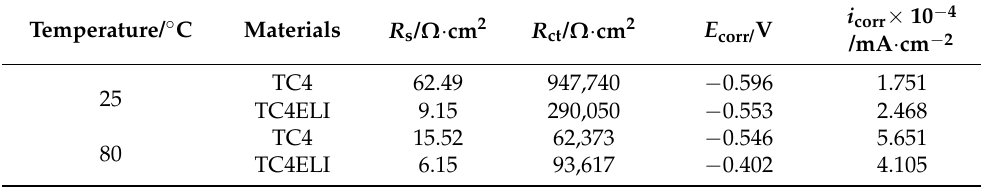
Table 8. Electrochemical parameters of titanium alloy in 35% NaCl + 0.4% Na 2 S